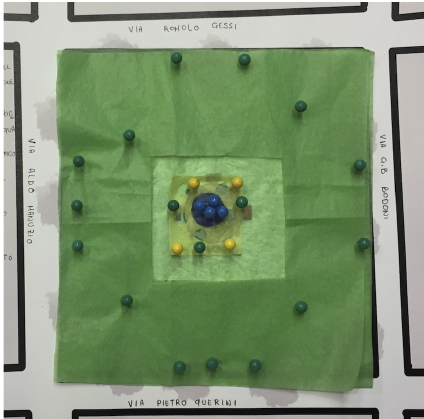
Figure 3: Visualization of sound perception in Piazza Testaccio Afternoon, 5.30 p.m. open eyed. Colors Legend as in Figure 1B.